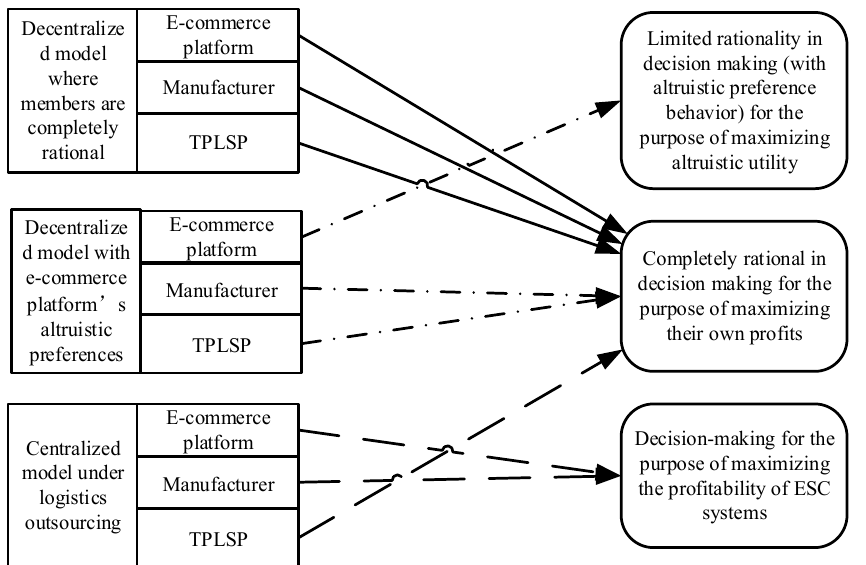
Figure 2. Decision makers’ objectives for different decision models.